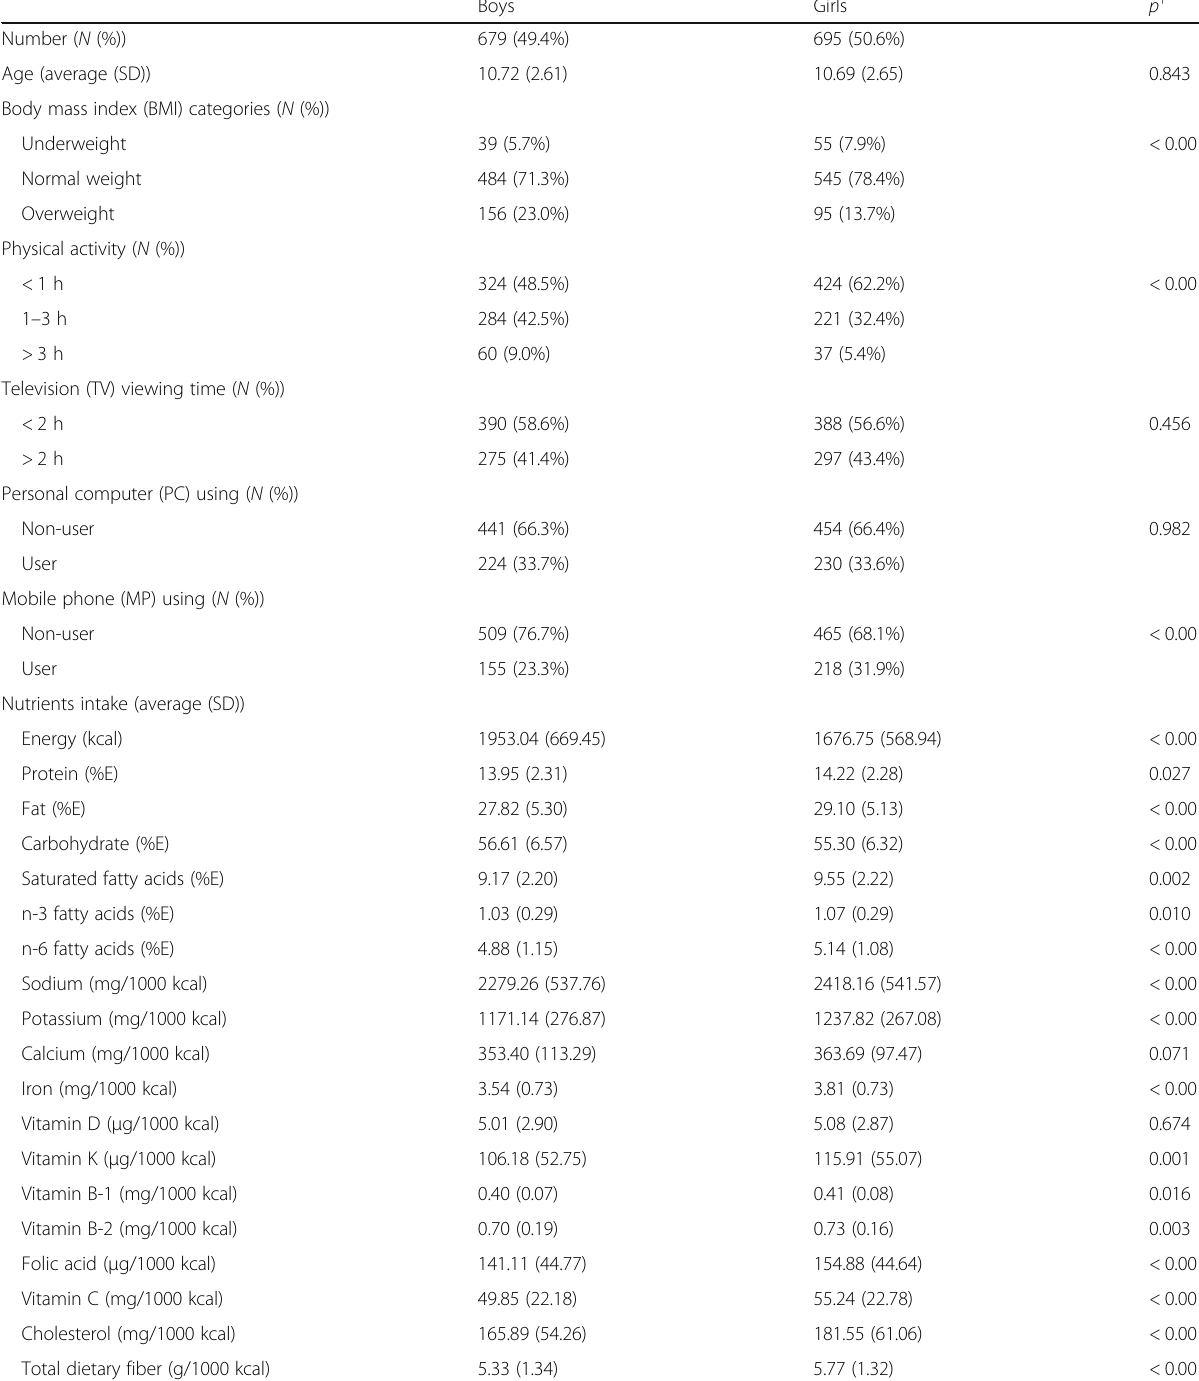
Table 1 The characteristics of the studied population